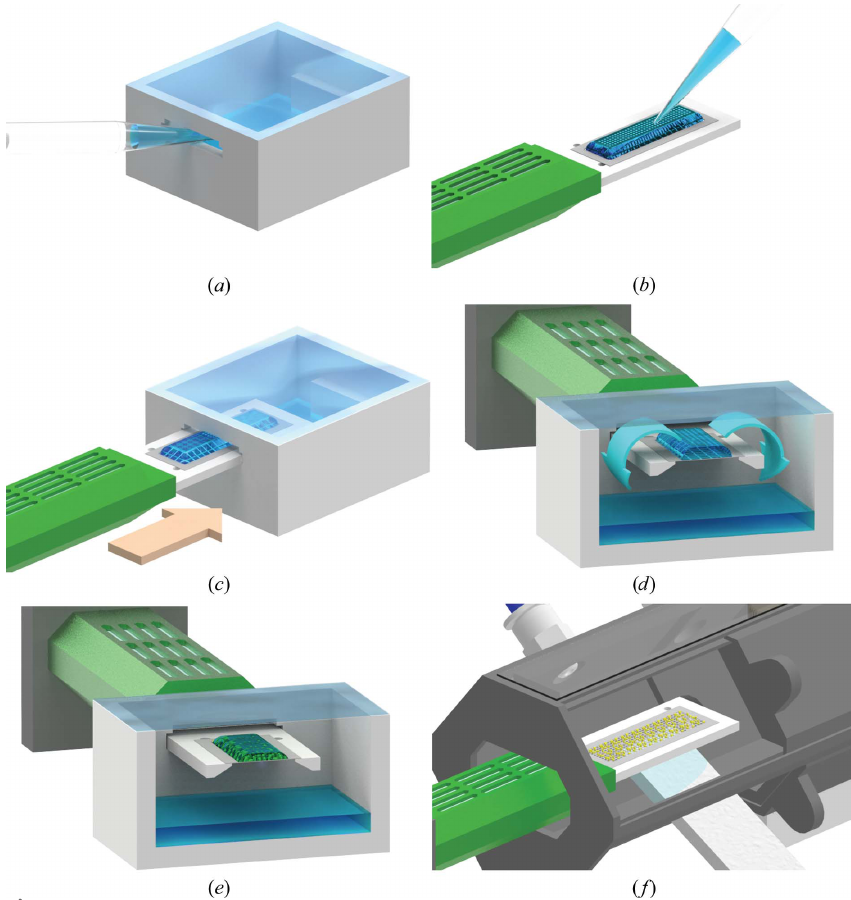
Figure 4 Procedure for on-chip crystallization using Roadrunner II chips. ( a ) The top opening of the crystallization chamber is sealed with transparent sticky tape and the chamber is subsequently filled with 5–10 ml reservoir solution through the side opening. ( b ) 100 m l of the protein–precipitant mixture is applied to the chip and carefully spread over the whole chip area using a pipette tip or a rectangular cover slide. ( c ) The chip holder is then inserted through the side opening of the chamber and the remaining cleft between the chamber and chip holder is sealed with Parafilm to minimize evaporation. ( d ) In the sealed chamber, the vapor-diffusion process leads to a decrease in the drop volume. ( e ) Crystal growth on the chip can be monitored by light microscopy using top light illumination. ( f ) After crystal growth has finished, the chip is removed from the crystallization chamber. Under a stream of humidified air, as shown here in a so-called ‘chip-loading station’, the mother liquor is carefully and thoroughly removed through the pores of the chip with a soft tissue. This handling step can be observed through the transparent window on top of the loading station. Afterwards, the humidor is slid over the chip and the naked crystals can be safely transported to the beamline for data